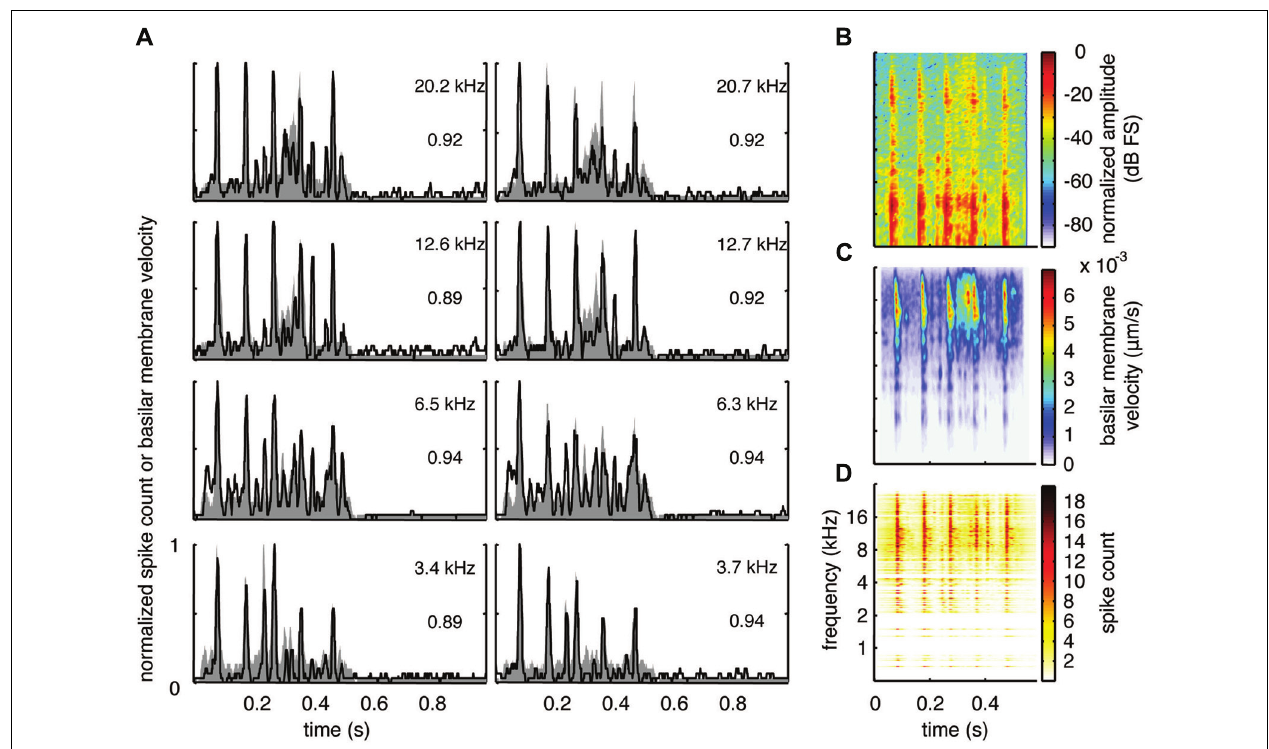
FIGURE 8 | Spectrotemporal representation for BT. Neural activity was recorded across a wide range of best frequency regions from 10 animals and compared to the corresponding frequency-specific DRNL outputs of the stimulus. (A) DRNL outputs and PSTHs for four different frequency laminae (shown in rows) corresponding to two different shanks (shown in columns) from the same recording probe. Black lines correspond to the PSTHs and gray shaded areas correspond to the DRNL outputs.The best frequency and the peak correlation value for each recording site are labeled on the top-right of each plot. (B) Spectrogram of the stimulus using the short-time Fourier